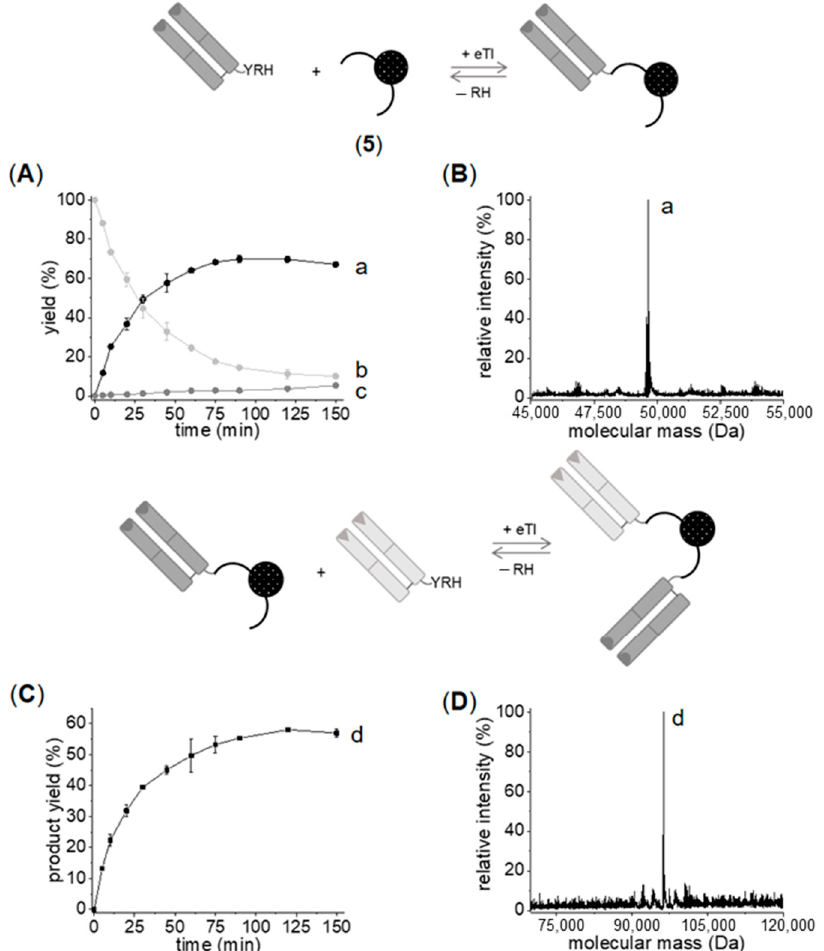
Figure 5. Results of the enzymatic C - to C -terminal coupling of anti-ErbB2-Fab-YRH and anti-ErbB3- Fab-YRH via linker 5 . ( A ) Reaction kinetics: the single modified product (black line) was mainly formed while only traces of the homodimeric product (dark grey line) were generated. a: anti-ErbB2- Fab-linker 5 , b: anti-ErbB2-Fab-YRH, c: homodimeric anti-ErbB2-linker 5 -anti-ErbB2-Fab; ( B ) MS analysis of the product purified by HIC, a: anti-ErbB2-Fab-linker 5 M calcd : 49,538 Da, M found : 49,539 Da; ( C ) Reaction course of anti-ErbB2-linker 5 -anti-ErbB3-bsFab synthesis with yields of about 60% analyzed by HIC, d: anti-ErbB2-linker 5 -anti-ErbB3-bsFab; ( D ) MS analysis of the purified bsFab, anti-ErbB2-linker 5 -anti-ErbB3-bsFab M calcd : 96,244 Da, M found : 96,245 Da. Reaction conditions: ( A ): 100 µM anti-ErbB2-Fab-YRH, 500 µM linker 5 , 10 µM eTl, 100 µM ZnCl 2 ; ( C ): 20 µM anti-ErbB2-Fab- linker 5 , 100 µM anti-ErbB3-Fab-YRH, 2.5 µM eTl, 50 µM ZnCl 2 ; ( A , C ): 100 mM HEPES/NaOH, pH 7.8, 100 mM NaCl, 10 mM CaCl 2 .